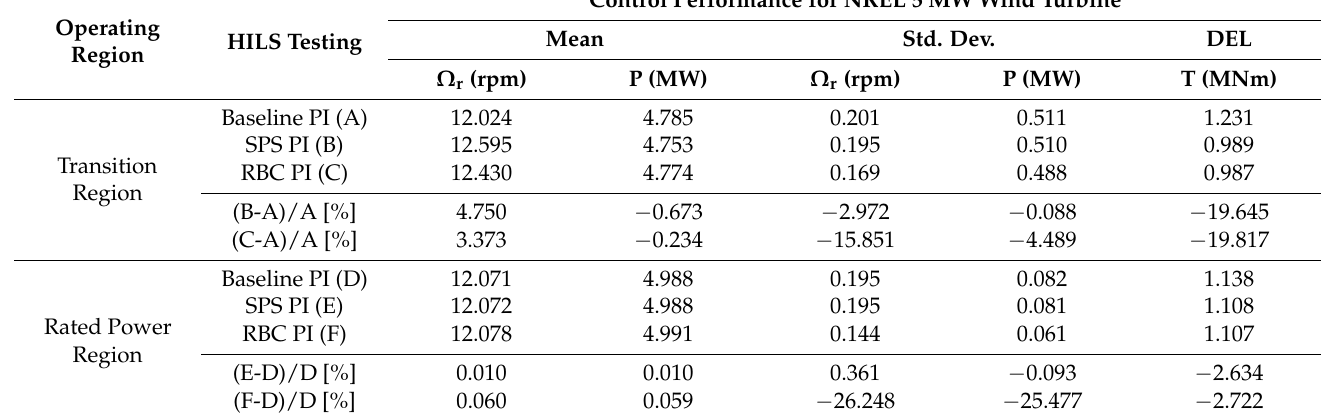
Table 5. Quantitative comparison of baseline PI, SPS PI, and RBC PI control performance for NREL 5MW wind turbine during